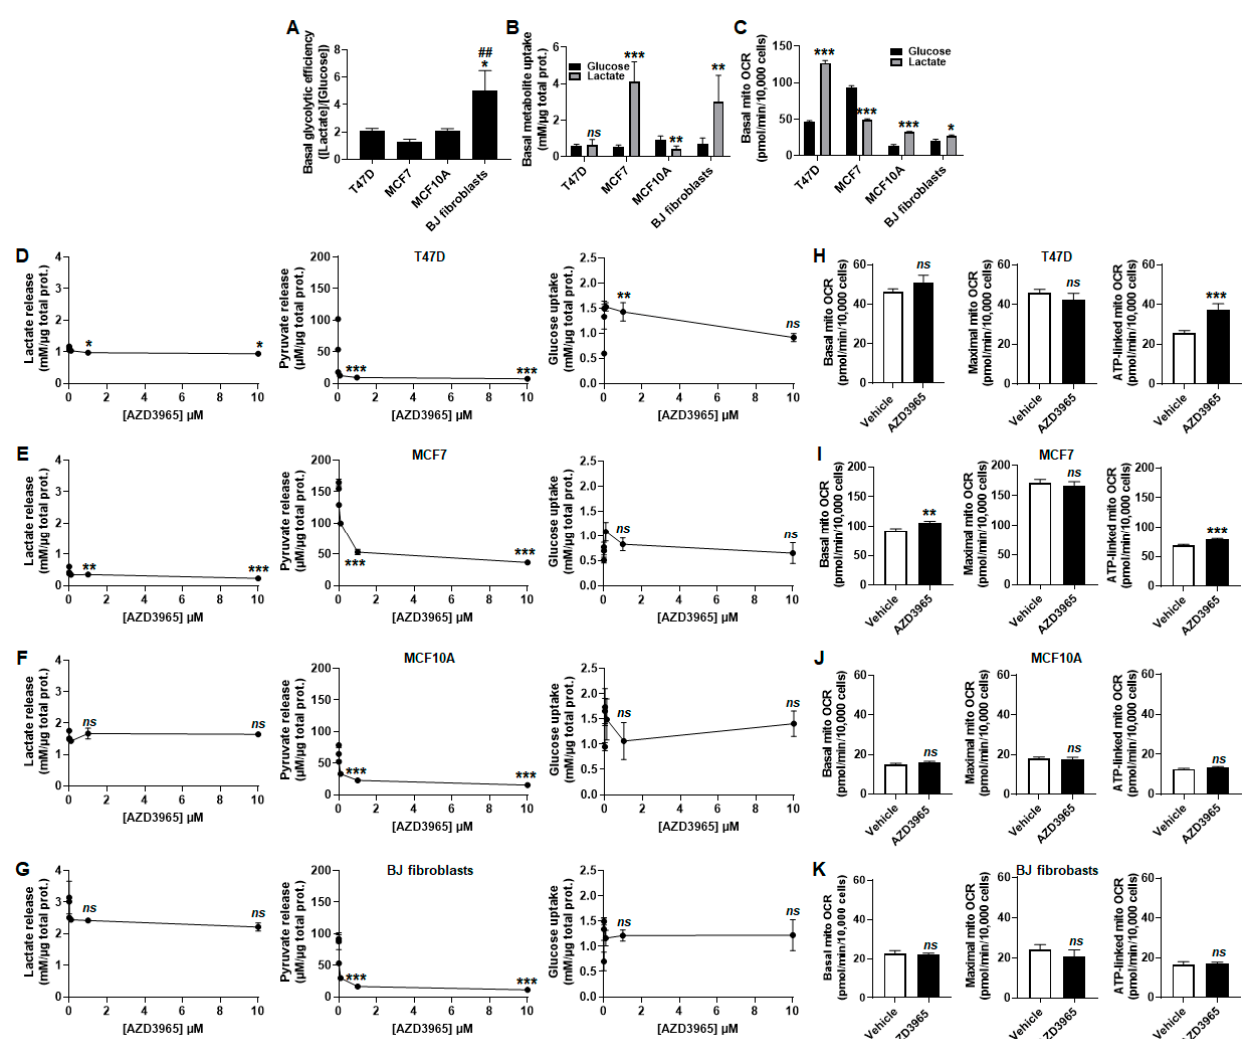
Figure 4. When MCT1 is used by proliferating cells to export lactate, AZD3965 induces an oxidative switch supporting ATP production in malignant but not in nonmalignant breast-associated cells. ( A ) Glycolytic efficiency of the cells cultured in medium containing 25 mmol/L glucose with 10 mmol/L GlutaMAX and 10% FBS, without added lactate, calculated as the lactate production/glucose consumption ratio ( n = 3–5). ( B ) Glucose and lactate uptake over 24 h by untreated T47D, MCF7, MCF10A cells and BJ fibroblasts cultured in medium containing 25 mmol/L glucose with 10 mmol/L GlutaMAX and 10% FBS, without added lactate (to determine basal glucose uptake, black bars) or in medium containing 10 mmol/L sodium L -lactate with no glucose, no glutamine and with 1% FBS (to determine basal lactate uptake, grey bars) ( n = 3–5). ( C ) Basal mito OCR of the cells cultured in medium containing 25 mmol/L glucose with 10 mmol/L GlutaMAX, 10% FBS and without added lactate (to determine glucose-dependent OCR, black bars) or in medium containing 10 mmol/L sodium L -lactate with no glucose, no glutamine and with 1% FBS (to determine lactate-dependent OCR, grey bars) ( n = 11–22). (D-K) Cells were metabolically characterized in medium containing 25 mmol/L glucose with 10 mmol/L GlutaMAX, 10% FBS and without added lactate. ( D ) Lactate release (right panel), pyruvate release (middle panel) and glucose uptake (right panel) over 24 h by T47D cells treated with increasing doses of AZD3965 ( n = 3–6). ( E ) As in D, but using MCF7 cells ( n = 3–6). ( F ) As in D, but using MCF10A cells ( n = 3–6). ( G ) As in D, but using BJ fibroblasts ( n = 3). ( H ) Basal mito OCR (left panel), maximal mito OCR (middle panel) and mito OCR linked to ATP production (right panel) of T47D cells treated for 24 h ± 10 µM AZD3965 ( n = 9–12). ( I ) As in H, but using MCF7 cells ( n = 11). ( J ) As in H, but using MCF10A cells ( n = 11). ( K ) As in H, but using BJ fibroblasts ( n = 11–12). All data are shown as means ± SEM. * p < 0.05, ** p < 0.01, *** p < 0.005, ns p > 0.05 compared to T47D cells ( A ), to cells in glucose-containing medium ( B , C ) or to vehicle ( D – K ); ## p < 0.01 compared to MCF7 cells; by one-way ANOVA followed by Dunnett’s post-hoc test ( A , D – G ) or Student’s t test ( B , C , H – K ).